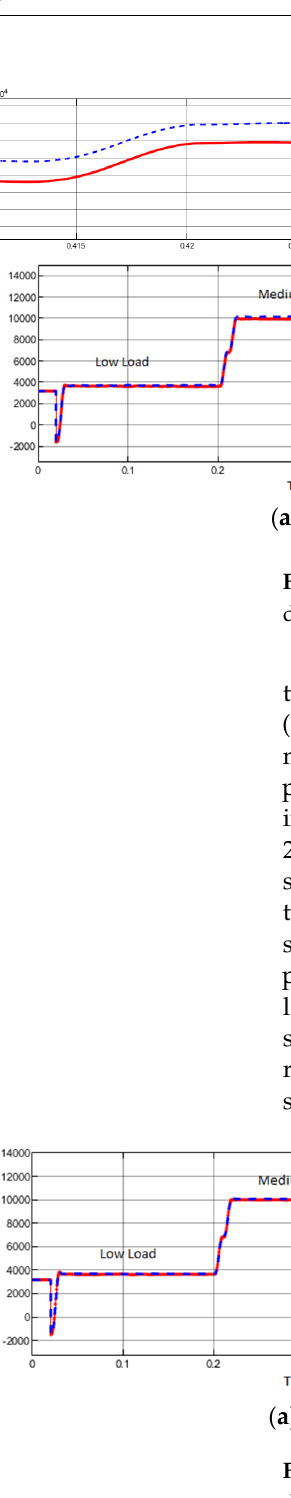
( b ) Figure 18. Output power of the inverter when low, medium, and high loads are supplied using conventional droop control for: ( a ) Active power; ( b ) Reactive power. The low load at t = 0.01 s to t = 0.2 s as P = 7 KW, and Q = 300 Var. A medium load starts at t = 0.2 s to t = 0.4 s as P = 20 KW, and Q = 2 KVar. A high load starts at t = 0.4 s to t = 0.6 s as P = 25 KW and Q = 3 KVar. Figure 18 illustrates the active and reactive power with conventional droop control under different load conditions. The maximum value of active power and reactive power were 13 KW, and 1.5 KVar, respectively, per inverter. In the conventional droop control, the first and second inverters generated oscillation output power, in addition, the over- shoot value at switching from one load to another is very high. From the results, sharing power is not accurate between inverters where the rate change of power is high, as shown in Figure 18. Figure 19 shows the droop control with the PSO algorithm, where the controller is activated by a sudden change in the active and reactive power, the load changes from low (7 KW, 300 Var) to medium (20 KW, 2 KVar) load, and after that, the load changes from medium (20 kW, 2 KVar) to high (25 kW, 3 KVar) load. During DG injection and sudden